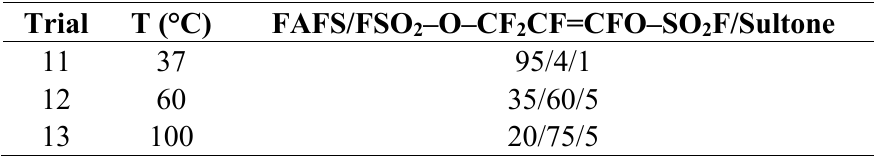
Table 3. FAFS and its side reaction products as a function of reaction